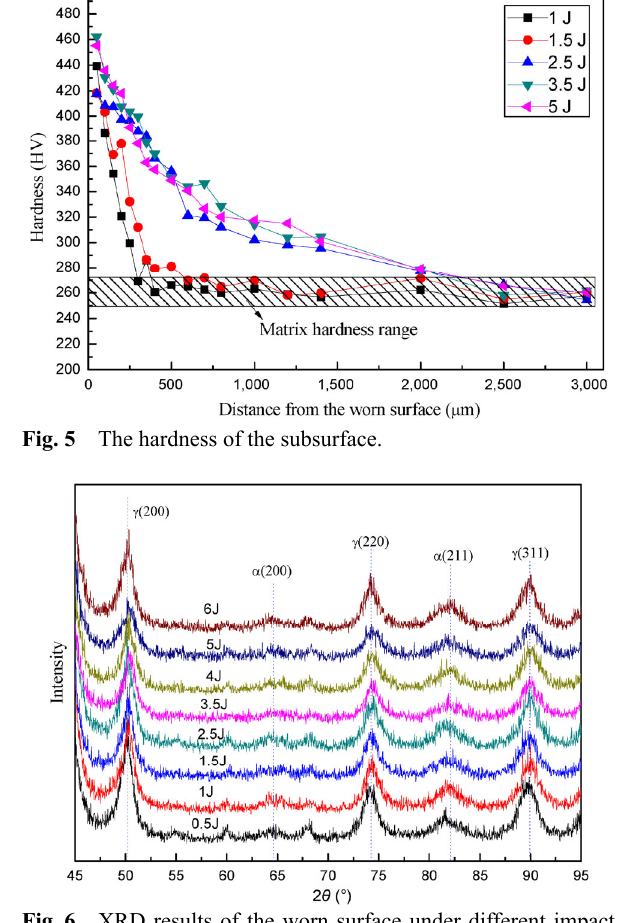
Fig. 6 XRD results of the worn surface under different impact energies from 0.5 − 6 J.